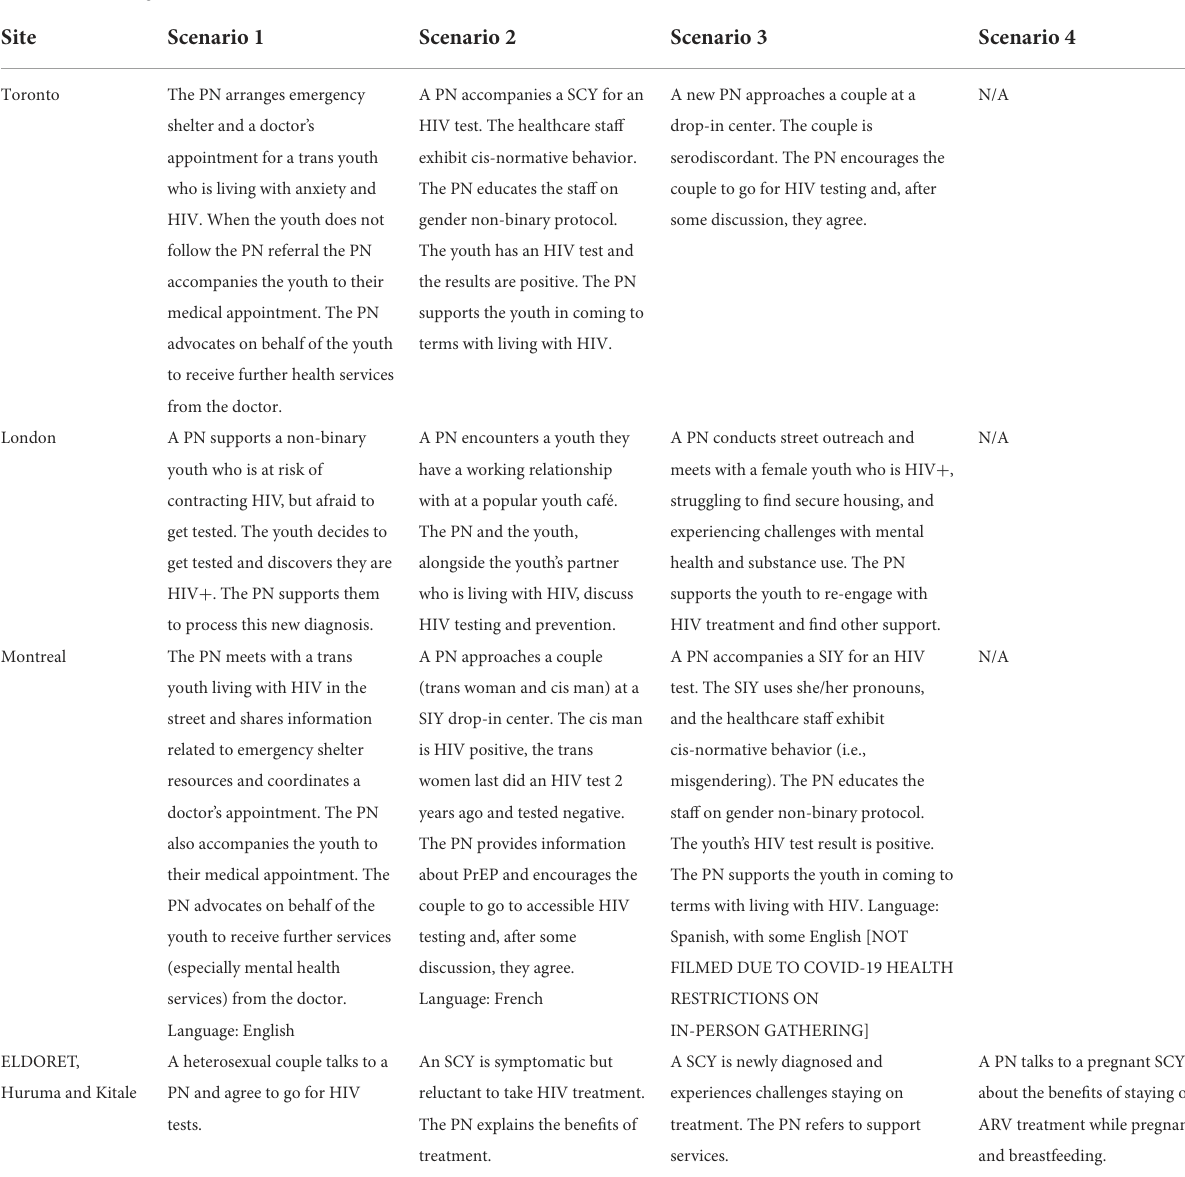
TABLE 1 Summary of TT